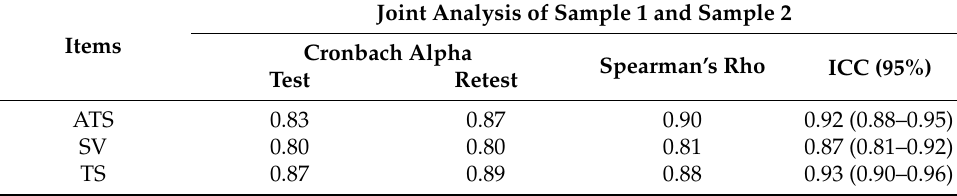
Table 5. Psychometric joint analysis of sample 1 and sample